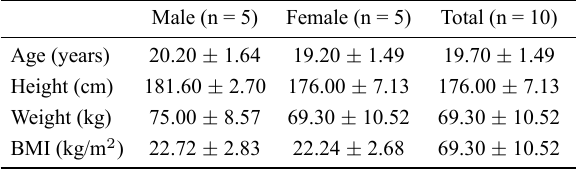
Table 1. Physical characteristics of subjects.